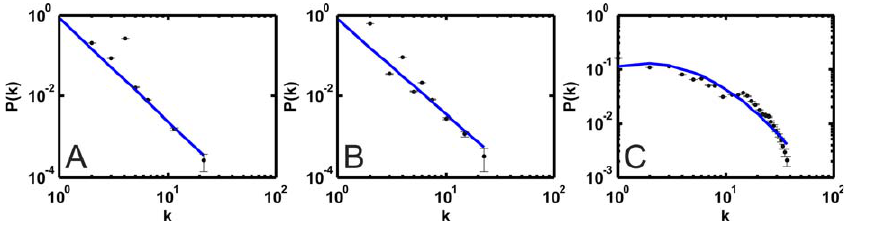
Figure 3. Degree Distribution for Evolved Networks Probability distribution P ( k ) based on functional (A), metabolic (B), and protein–protein (C) representation of interactions. The functional distribution decays approximately as P ( k ) : 1/ k c with c ¼ 2.53 (minimum T ¼ 20 points per bin, r 2 ¼ 0.91, fit not shown). Excluding the point at k ¼ 4 yields c ¼ 2.52 with r 2 ¼ 0.97 (blue line, T ¼ 20). The metabolic distribution decays with c ’ 2.34 (line, T ¼ 20, r 2 ¼ 0.87). The protein–protein distribution was fitted to an exponential (binning threshold T ¼ 100, r 2 ¼ 0.88). Error bars are standard